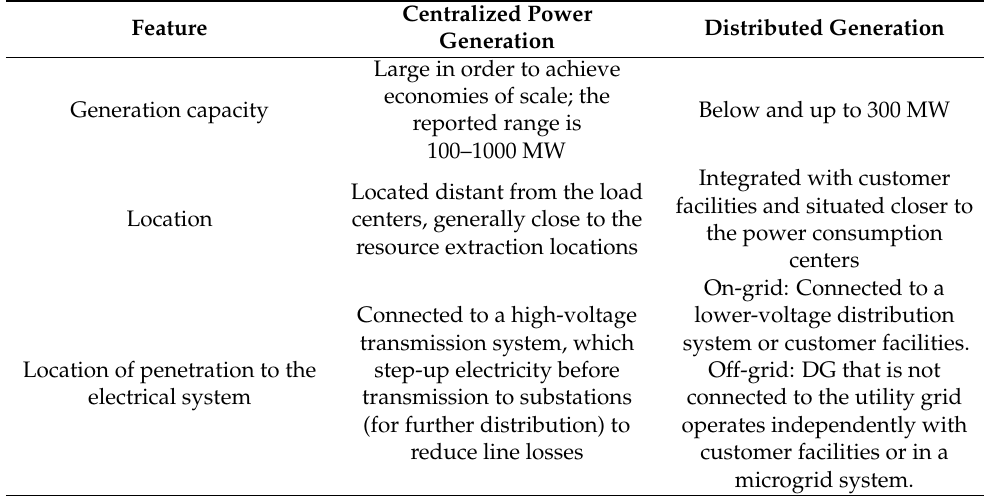
Table 1. Comparison of centralized and distributed power generation systems